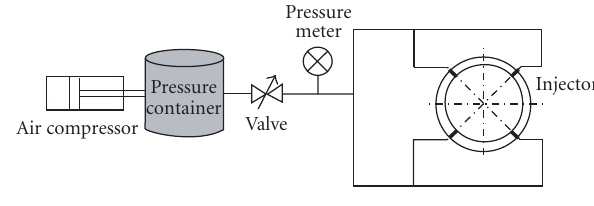
Figure 5: Schematic of injection